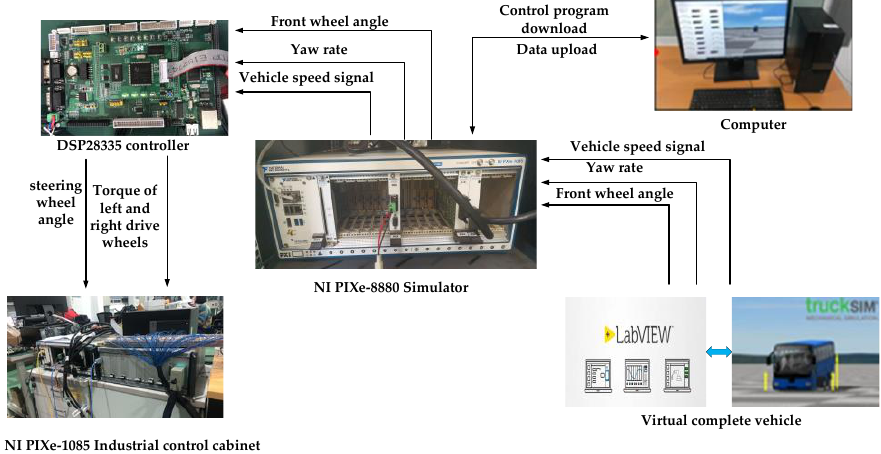
Figure 11. Hardware-in-the-loop test